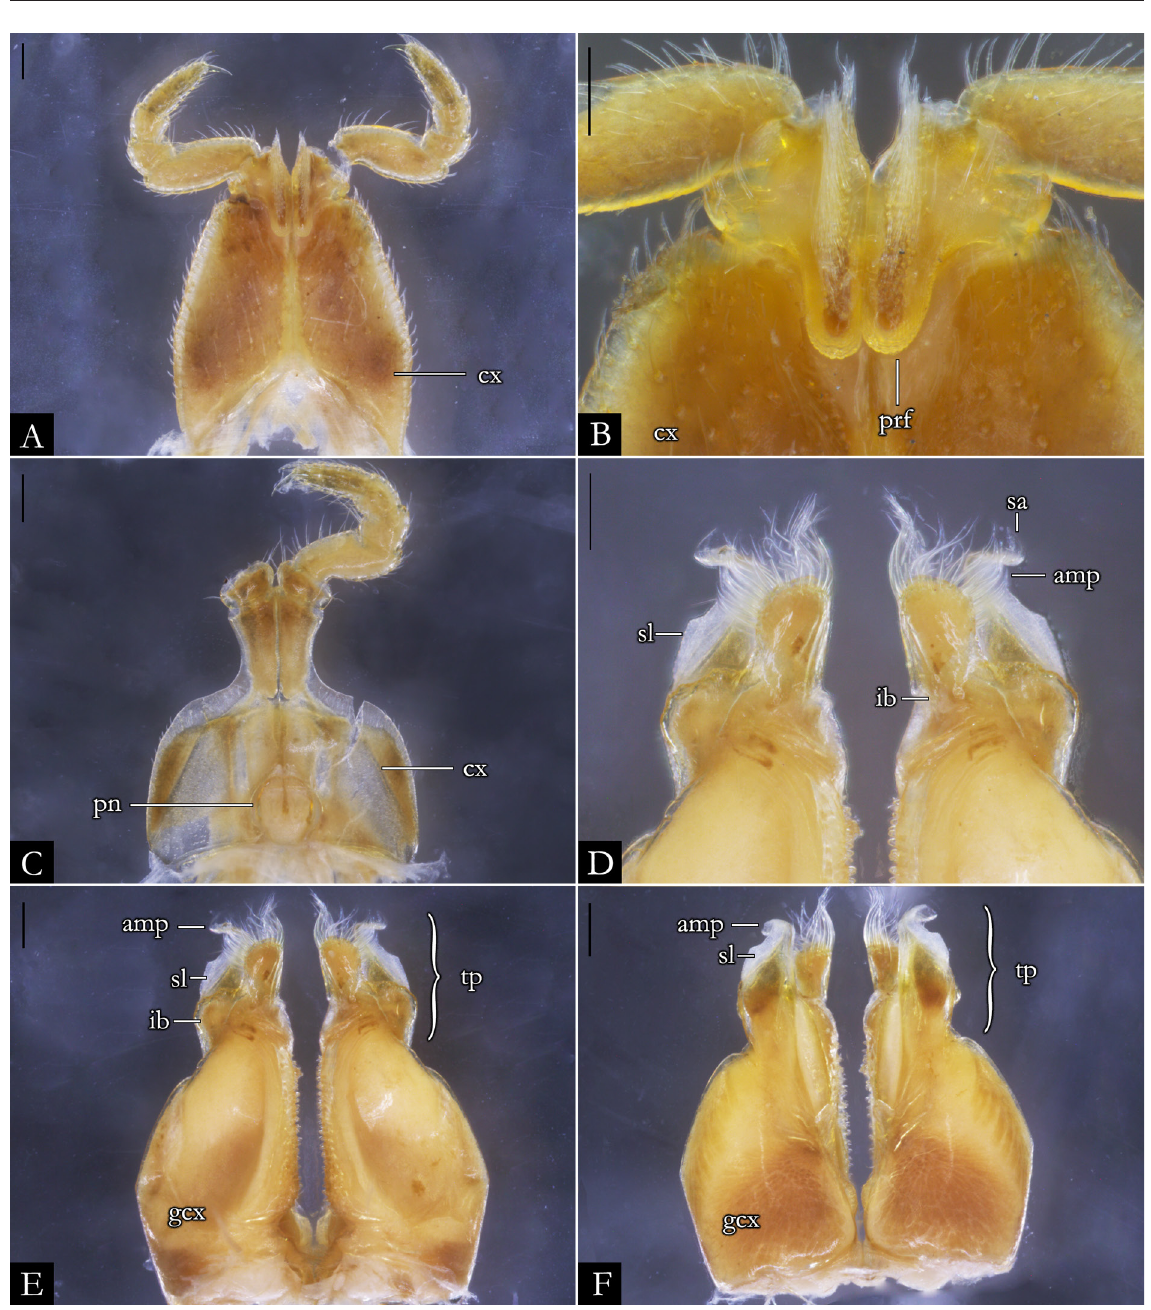
Fig. 156. Pseudonannolene insularis sp. nov., ♂ (IBSP 1233). A . First leg-pair. B . Detail of prefemur. C . Second leg-pair. D . Detail of telopodites, in anal view. E . Gonopods, in anal view. F . Gonopods, in oral view. Abbreviations: see Material and methods. Scale bars = 0.2